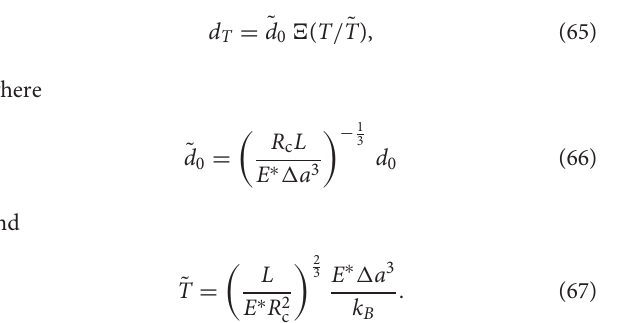
FIGURE 6 | Reduced thermal displacement d T / ˜ d 0 as a function of reduced T / ˜ T for different Hertzian contact realizations. The default temperature t = model (black circles) is defined in the method section. In one case, load was increased by a factor of two (red squares), and in another case, the radius of curvature was increased by a factor of eight (orange diamonds) with respect to the default values. Finally, values found for blunt atomic-force microscope (AFM) tips were also considered: 1 a 2.5 Å, R c 200 nm, E ∗ 100 GPa, = = = and L 200 nN (green triangles). Solid blue and red line show the low- and = intermediate-temperature approximation from Equation (68). The dashed brown line represents the high-temperature limit of Equation